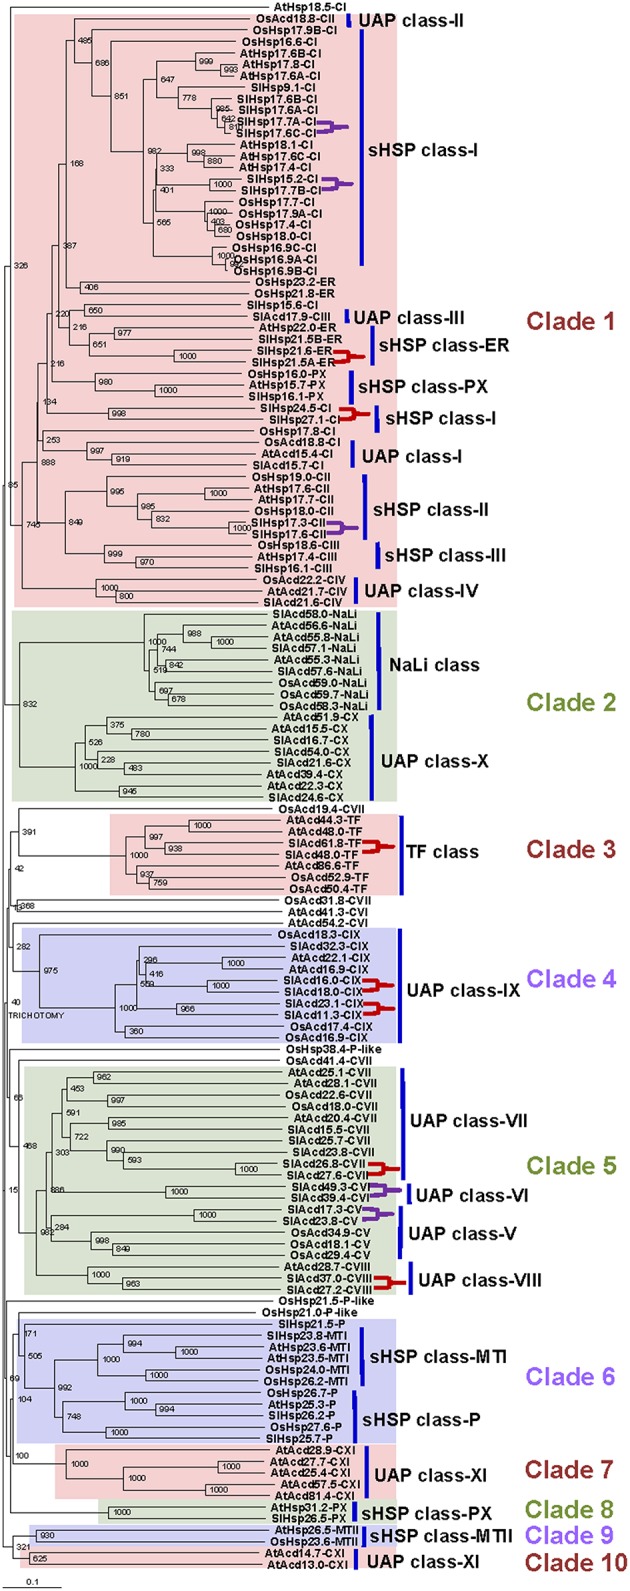
Phylogenetic analysis of tomato Acd gene family. The tree was derived by Neighbor-joining method with bootstrap analysis (1000 replicates) from alignment of ACD proteins of tomato, A. thaliana and O. sativa using ClustalX2.1. The tree was analyzed with TreeView 1.6.6. Numbers at the nodes denote bootstrap values. Tree branches with bootstrap value above 50% were delineated to represent a clade. The different clades are highlighted and numbered 1–10. The sub-clades representing different ACD proteins have being marked by bold vertical lines. The paralogous pairs are marked by purple and red brackets for tandem and segmental duplication events, respectively. The genetic distances are indicated by the horizontal bar.